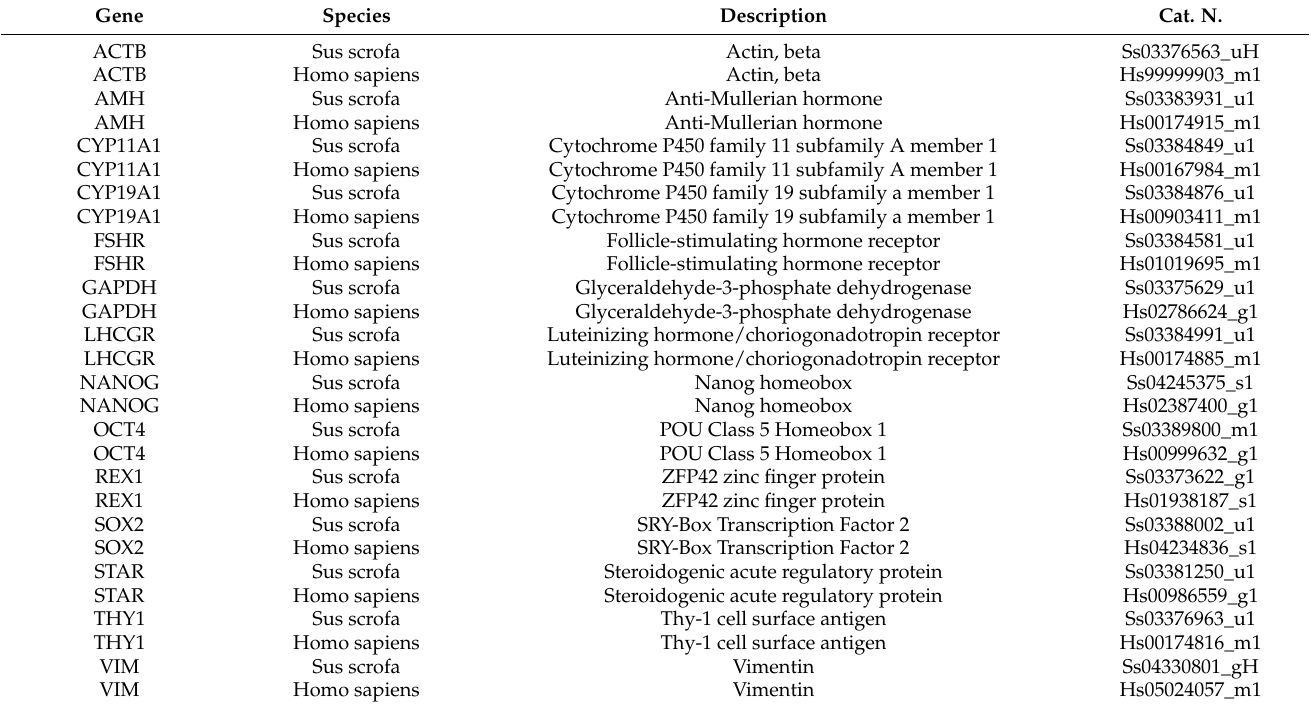
Table 1. List of primers used for quantitative PCR